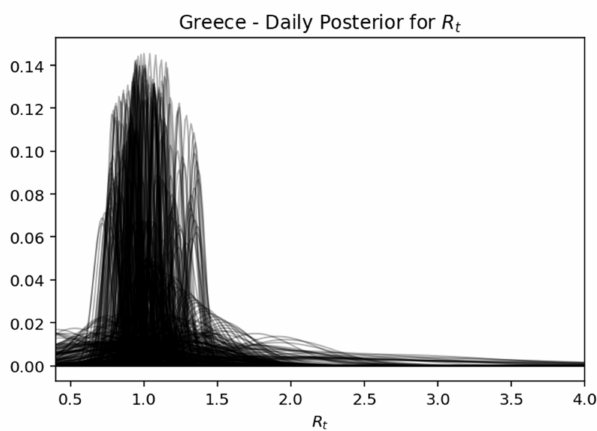
Figure 17. Greece—daily posterior for R t